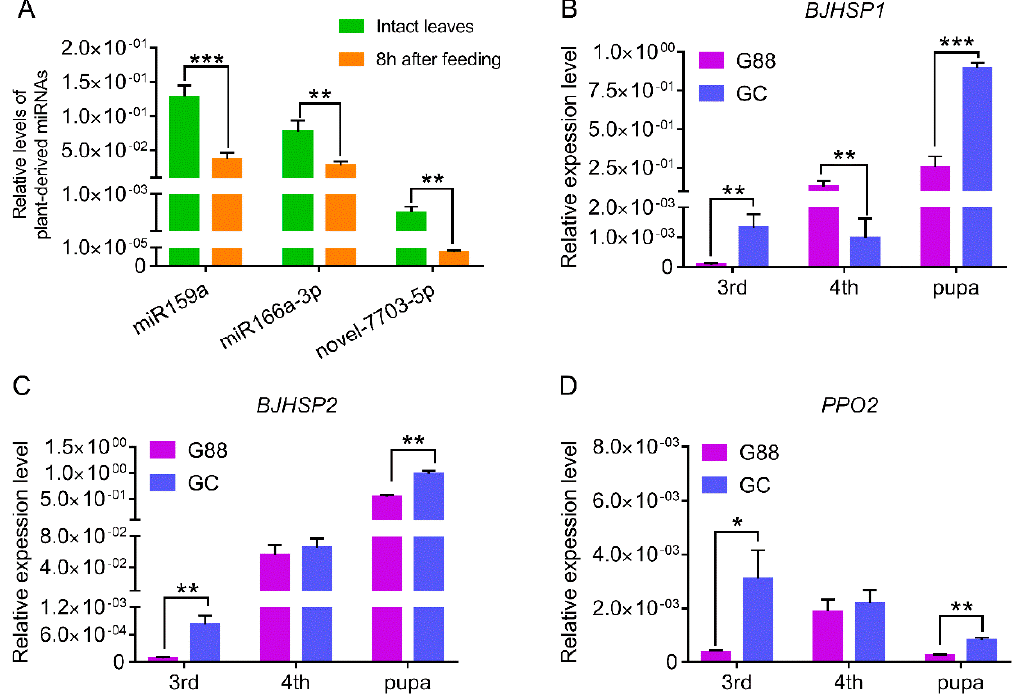
< 0.001,) ( B – D ). Expression of BJHSP1 ( B ), BJHSP2 ( C ) and PPO2 ( D ) in the 3 rd instar larvae, 4 th instar larvae instar larvae, 4 th instar larvae and newly-emerged pupae of G88 and GC strains. Data were presented and newly-emerged pupae of G88 and GC strains. Data were presented as mean ± SD (Student’s t test, * p < as mean ± SD (Student’s t test, * p < 0.05, ** p < 0.05, ** p < 0.01).